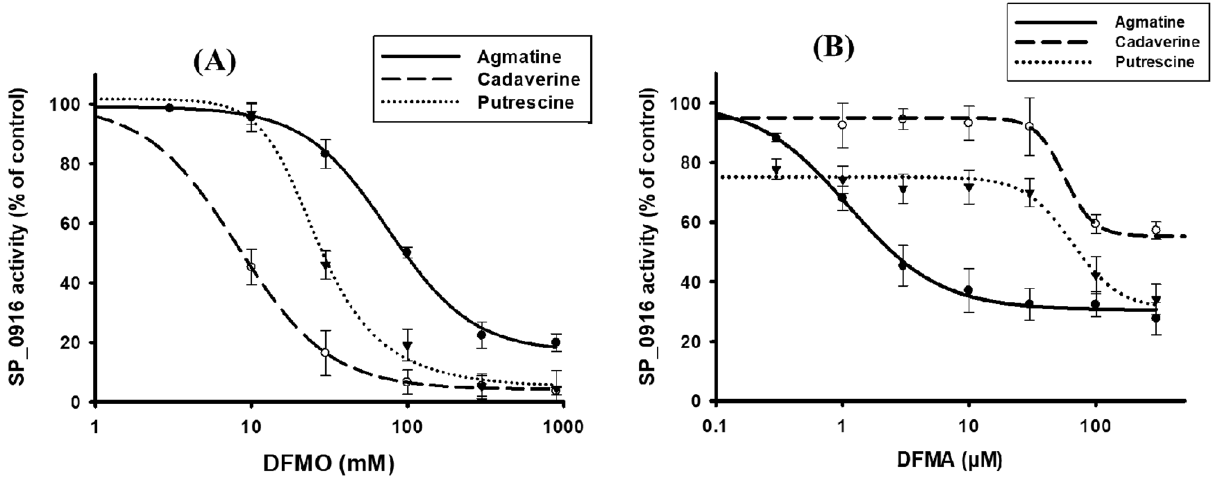
Figure 9. DFMO ( A ) and DFMA ( B ) inhibit decarboxylase activities of ADC. We determined DFMO/ DFMA IC 50 values for the following reactions catalyzed by ADC: arginine to agmatine, lysine to cadaverine, and ornithine to putrescine. Enzyme activity without inhibitor is referred to as a control activity. LCMS based estimation of IC 50 was determined by varying the concentration of the indicated inhibitor (a) DFMO or (b) DFMA and measuring the decarboxylase activity. Sigma Plot v. 12 was used to fit the curve through the points and IC 50 values were interpolated from the fitted curve. Our data shows that DFMO IC 50 for agmatine (75.1 ± 5.5 mM) > putrescine (26.6 ± 4.1 mM) > cadaverine (8.2 ± 0.2 mM) while IC 50 of α-difluoromethylarginine (DFMA) that is specific for arginine decarboxylase show that cadaverine (56.6 ± 11.9 µM) > putrescine (40.5 ± 11.6 µM) > agmatine (1.1 ± 0.1